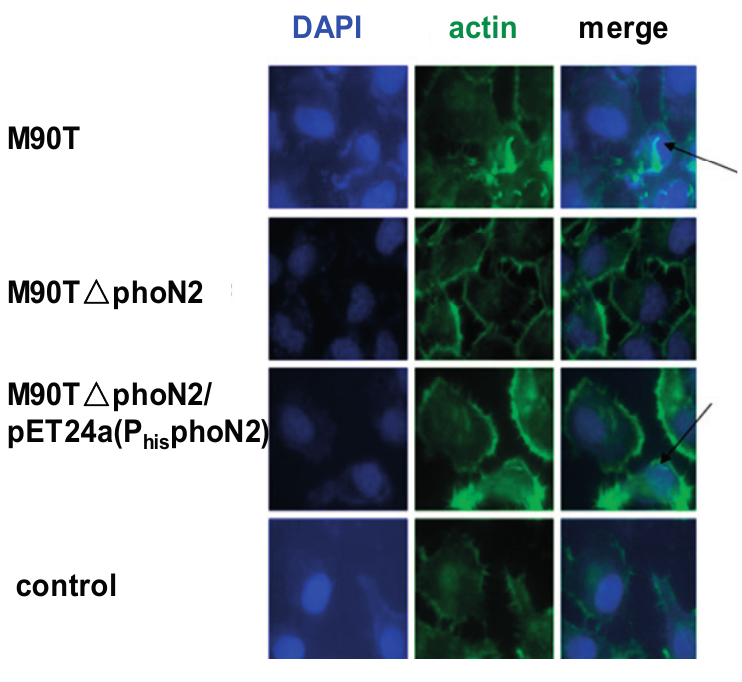
Figure 9. Immunofluorescence assay analysis of